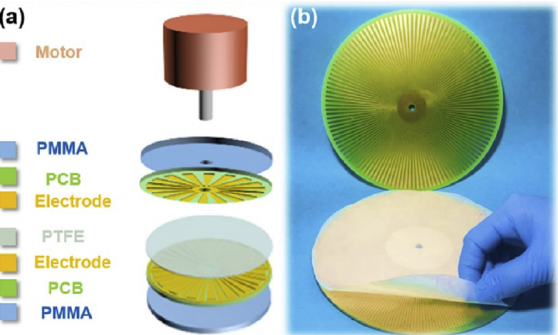
Figure 6. ( a ) Exploded view; ( b ) photograph of a typical rotary disc-shaped triboelectric nanogenera- tor (reprinted from [83], copyright (2019), with permission from